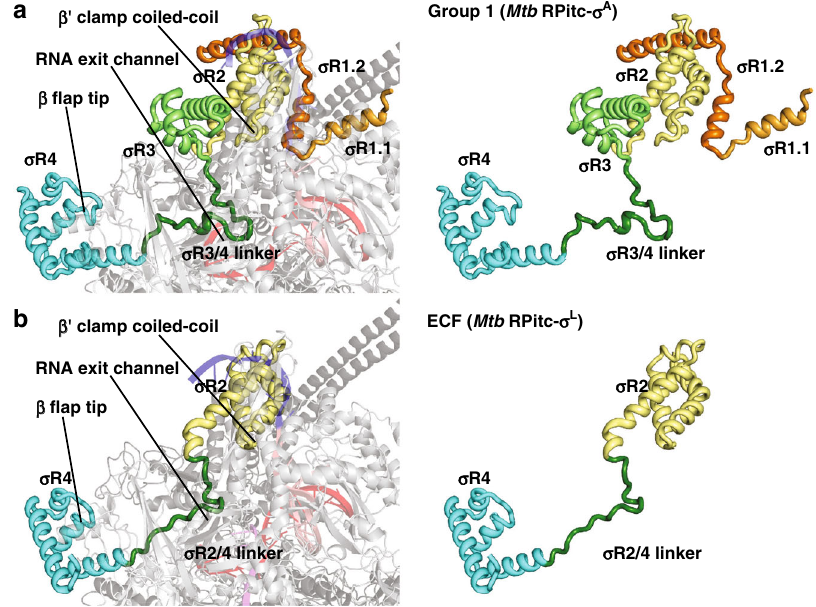
Fig. 2 Protein – protein interactions between group-1 and ECF σ factors and RNAP core enzyme. a Protein – protein interactions by group-1 ( σ A ) σ factor. b Protein – protein interactions by ECF ( σ L ) σ factor. Colors are as in Fig. 1. See Supplementary Fig.